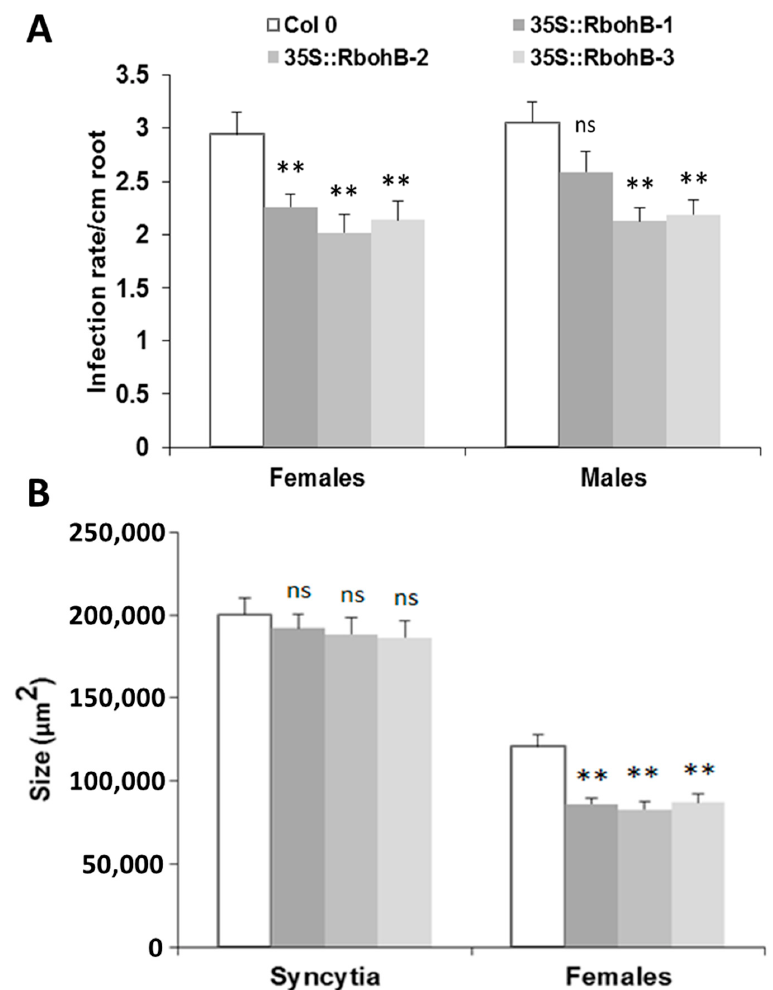
Figure 4. H. schachtii resistance test. The resistance of overexpression lines of RbohB was compared to wild type plants after infection with H. schachtii . ( A ), Number of male and female nematodes per cm of root length, calculated at 15 dpi. Infection rate is shown in column sets, with asterisks indicating significant di ff erences (** p < 0.05; ANOVA and LSD). The statistical significance was determined by three independent replicates. Values are means ± SE, n = 15. The bar shows standard error for the mean. Ns, not significant ( B ), Size of female syncytia and female nematodes at 14 dpi. Five syncytia were selected randomly from three independent replicates (total = 15) and the size of syncytia and associated female nematodes were measured. Data were analyzed for significance di ff erence using ANOVA ( p < 0.05) and LSD. Values are means ±